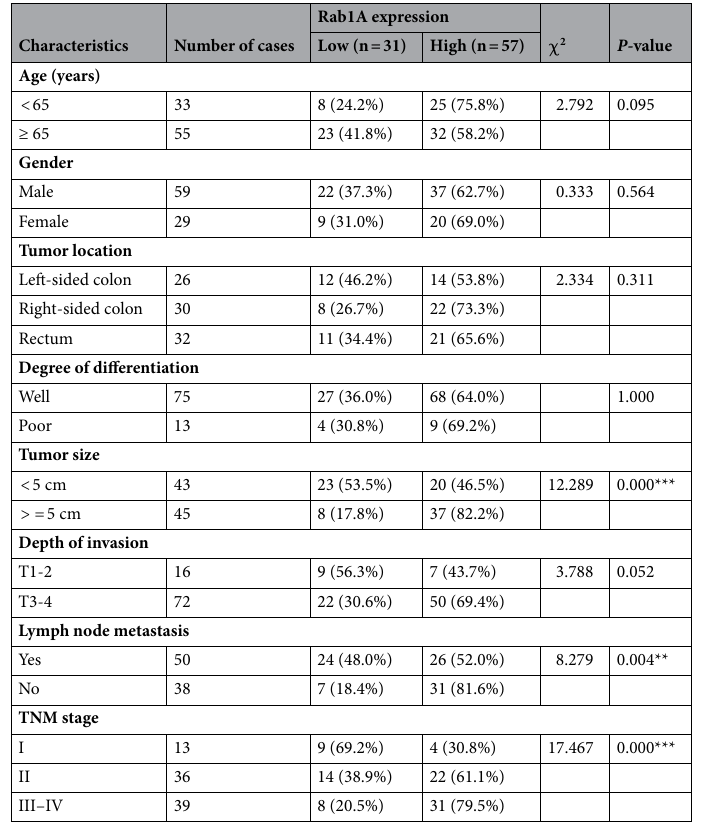
Table 1. Relationship between Rab1A expression and clinicopathological characteristics of CRC patients. ** P < 0.01, *** P <